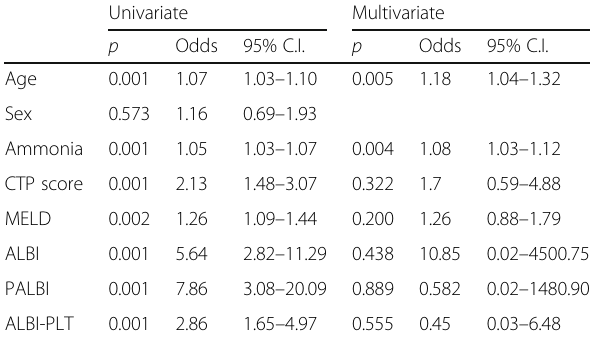
Table 2 Univariate and multivariate analysis of MHE predictors